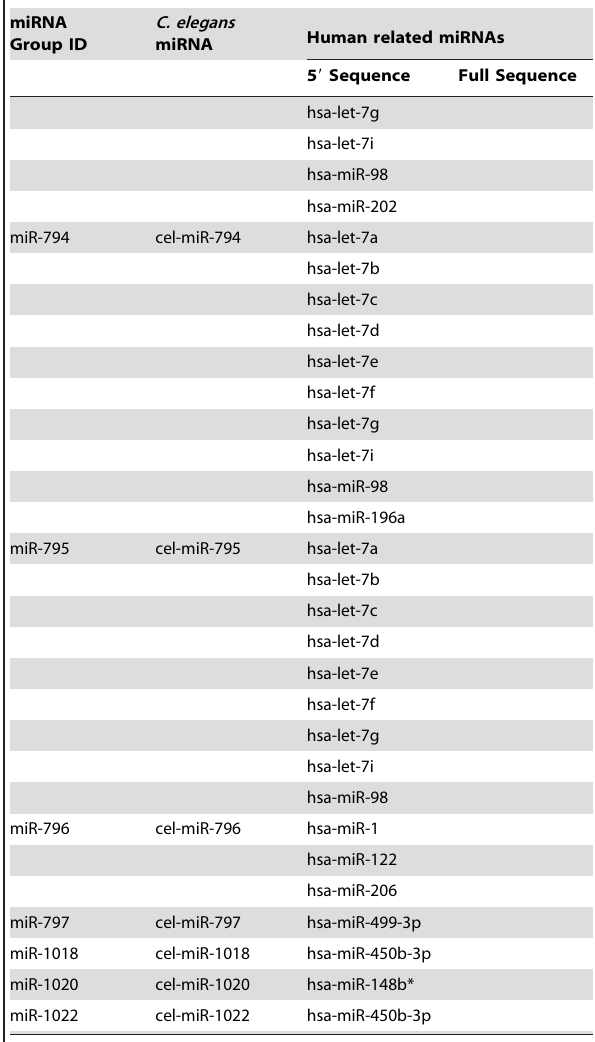
Table 4. cont. Table 4.